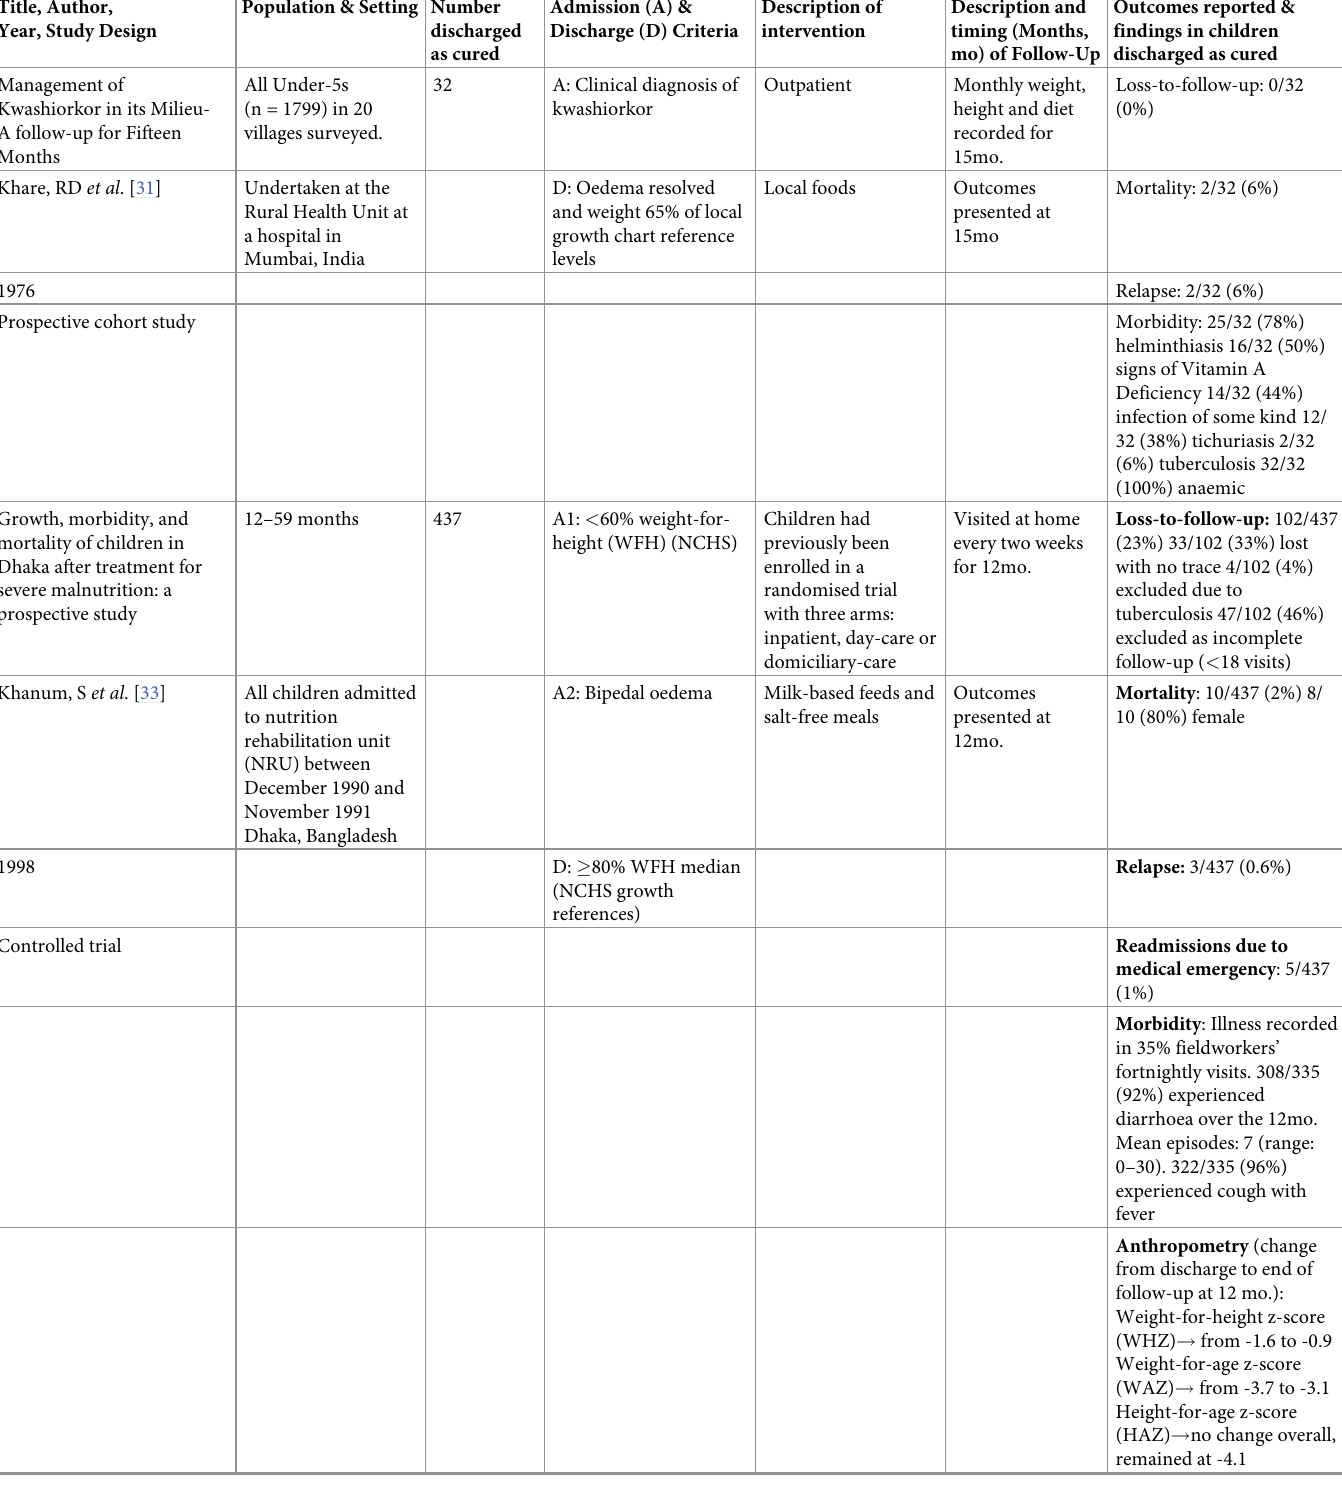
Table 1. Summary of results of studies included in